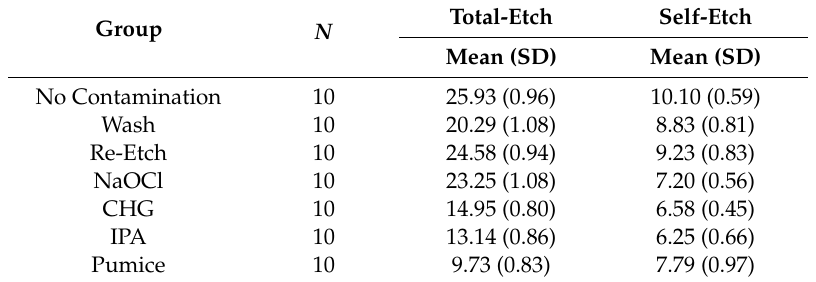
Table 2. Descriptive statistics of the Shear bond strength (Mpa) measured in the di ff erent groups.